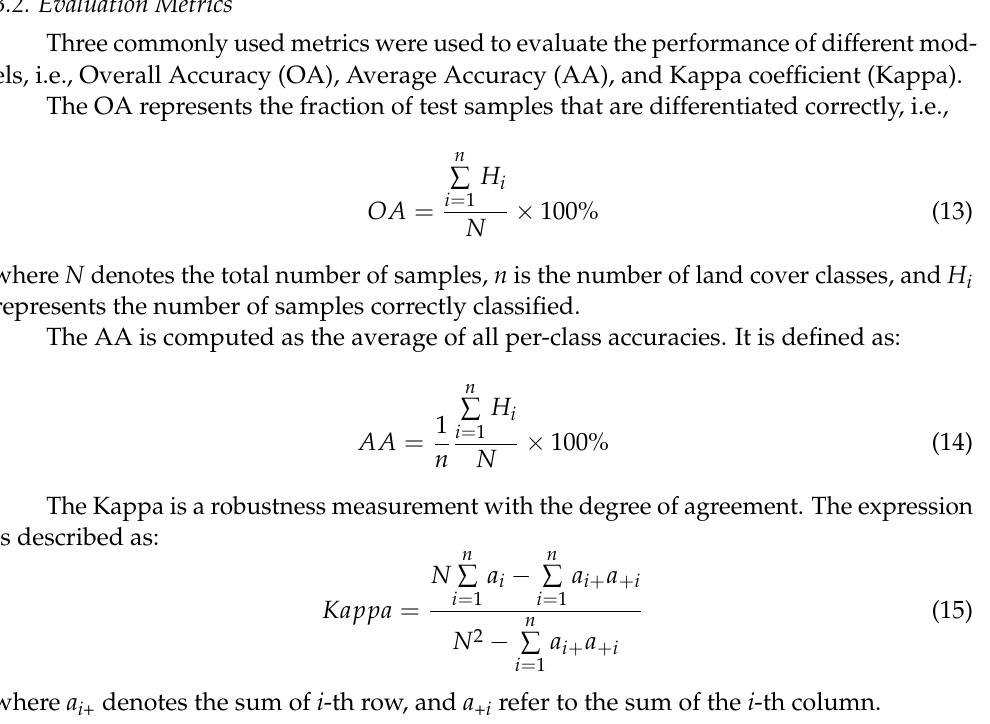
Table 2. The detailed information of three hyperspectral data sets. IP PU KSC Type of Sensor AVIRIS ROSIS AVIRIS Spatial Resolution 20 m 1.3 m Spatial Size 145 × 145 610 × 340 512 × 614 Spatial Resolution 0.4–2.5 µ m 0.43–0.86 µ